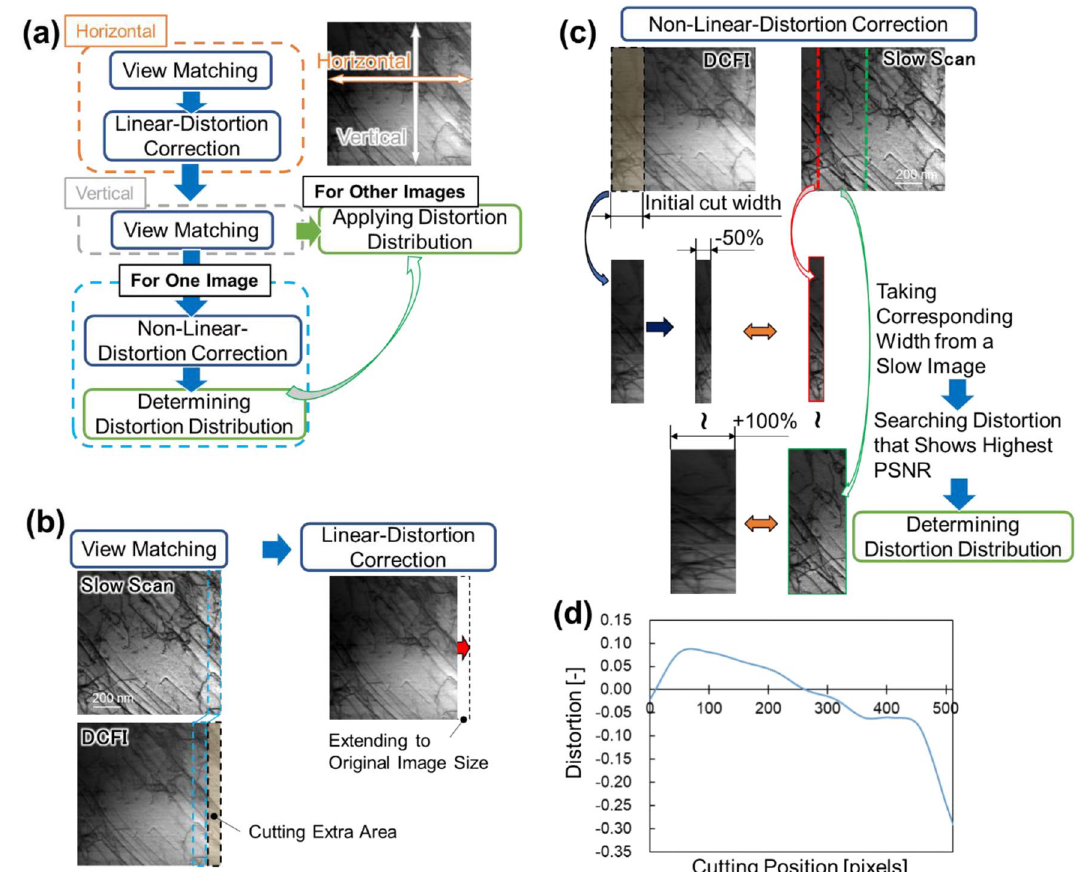
Figure 7. Overview of distortion correction process. This process is roughly divided into three processes, i.e., view matching, linear distortion correction, and non-linear distortion correction, as shown in ( a ) flow chart. ( b )The view matching and the linear distortion correction are conducted before ( c ) the non-linear distortion correction. The calculated distortion distribution is shown in ( d